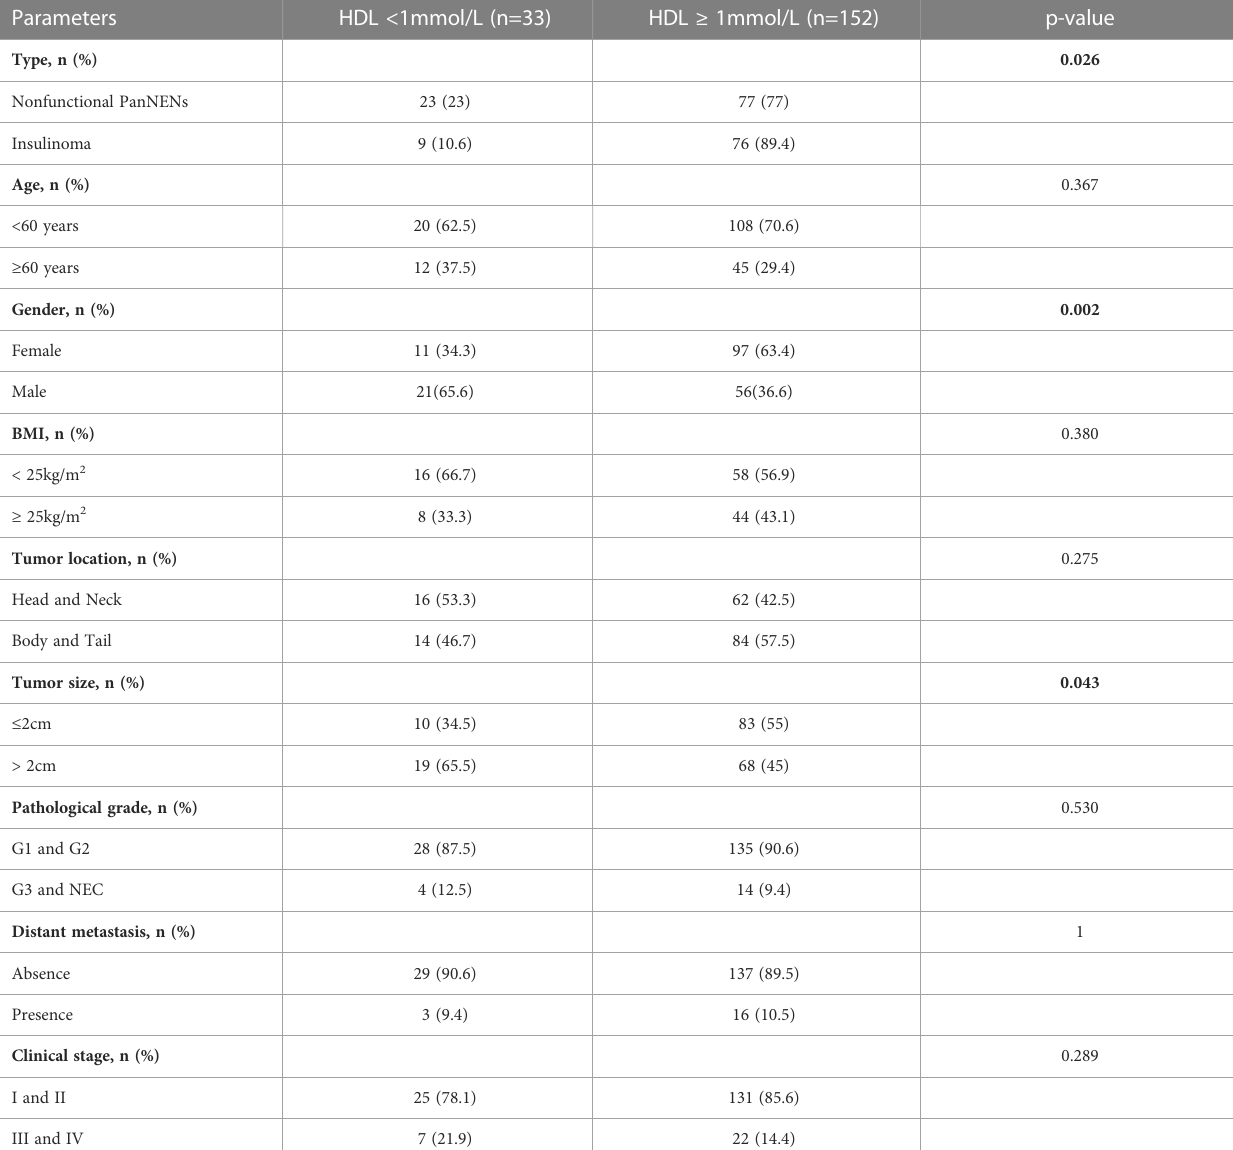
TABLE 3 Comparison of clinicopathologic parameters of